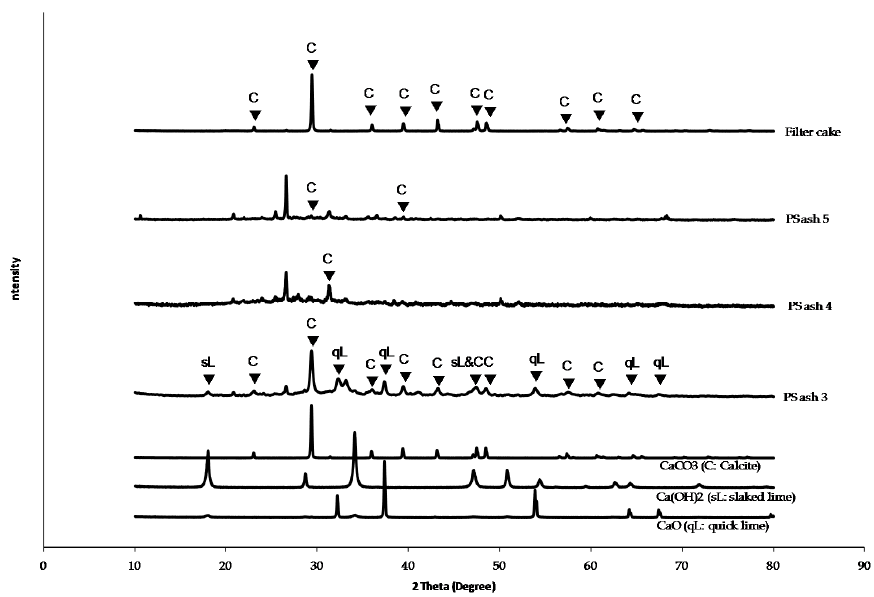
Figure 3. Thermogravimetric curves showing the thermal decomposition of Ca(OH) 2 , CaCO 3 , and additives in a N 2 atmosphere.